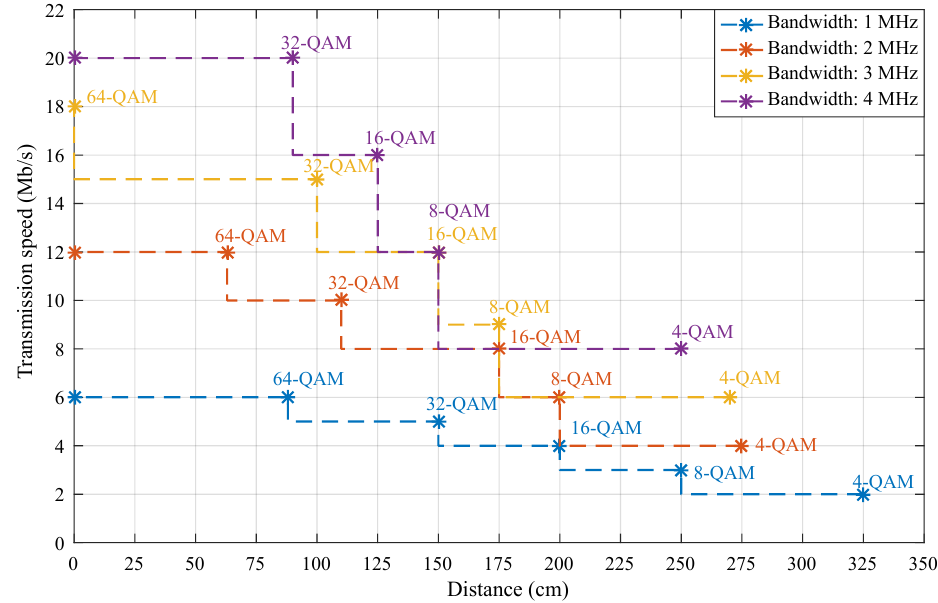
Figure 7. Transmit speed/distance from center relationship for ceiling light with different M-QAM and